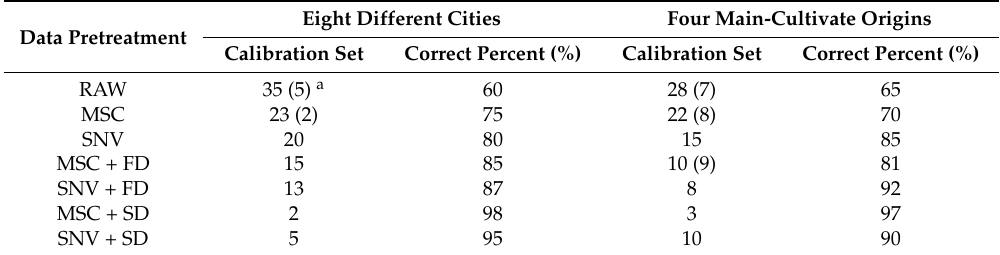
Table 5. Numbers that had been incorrectly classified for G. elata samples using discriminant analysis (DA) models on the raw spectra and those with various transformation ( n = 100).